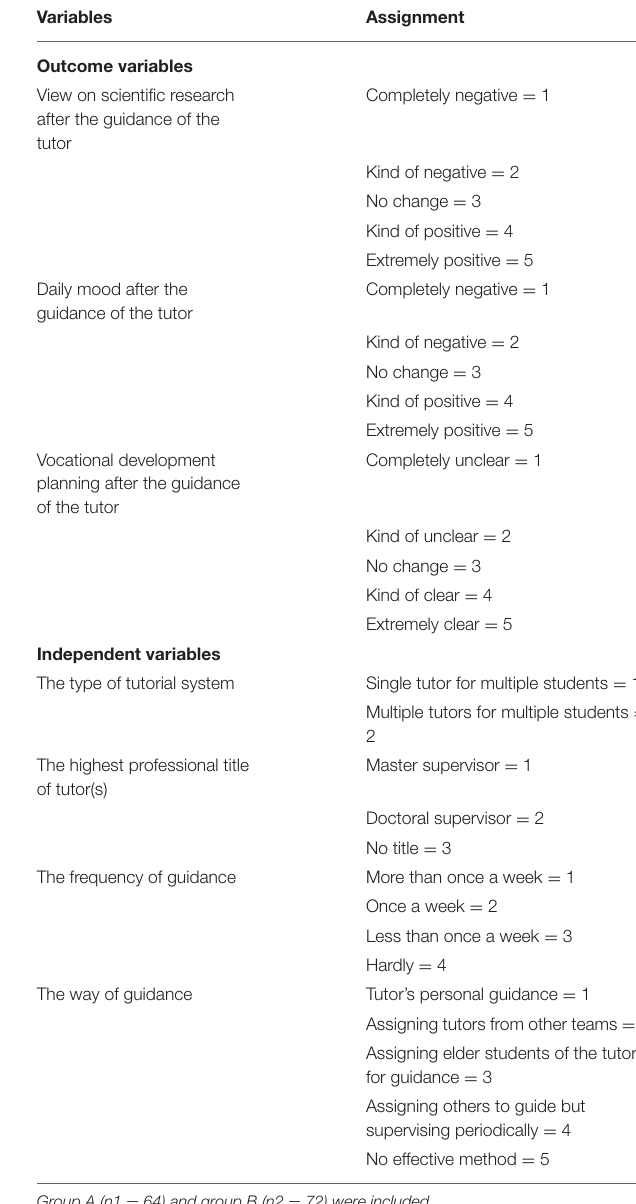
TABLE 2 | Variable assignment for ordinal and multinomial-logistic regression analysis of influential factors of different subjective influence of different tutor